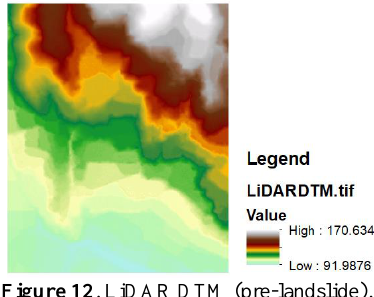
Figure 12 . LiDAR DTM